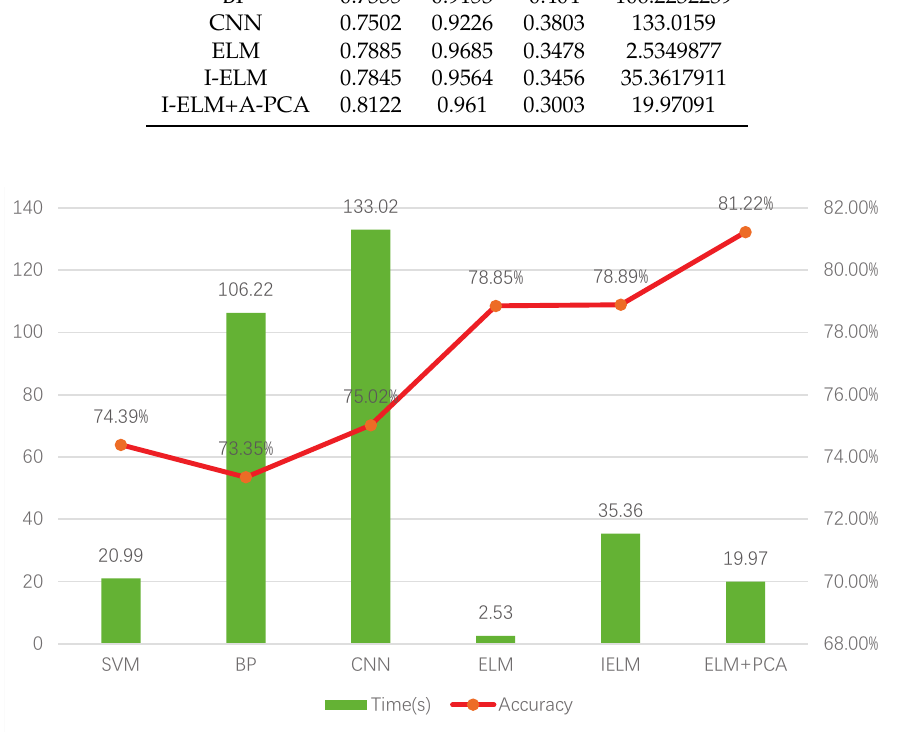
Figure 5. The average time and maximum accuracy of different